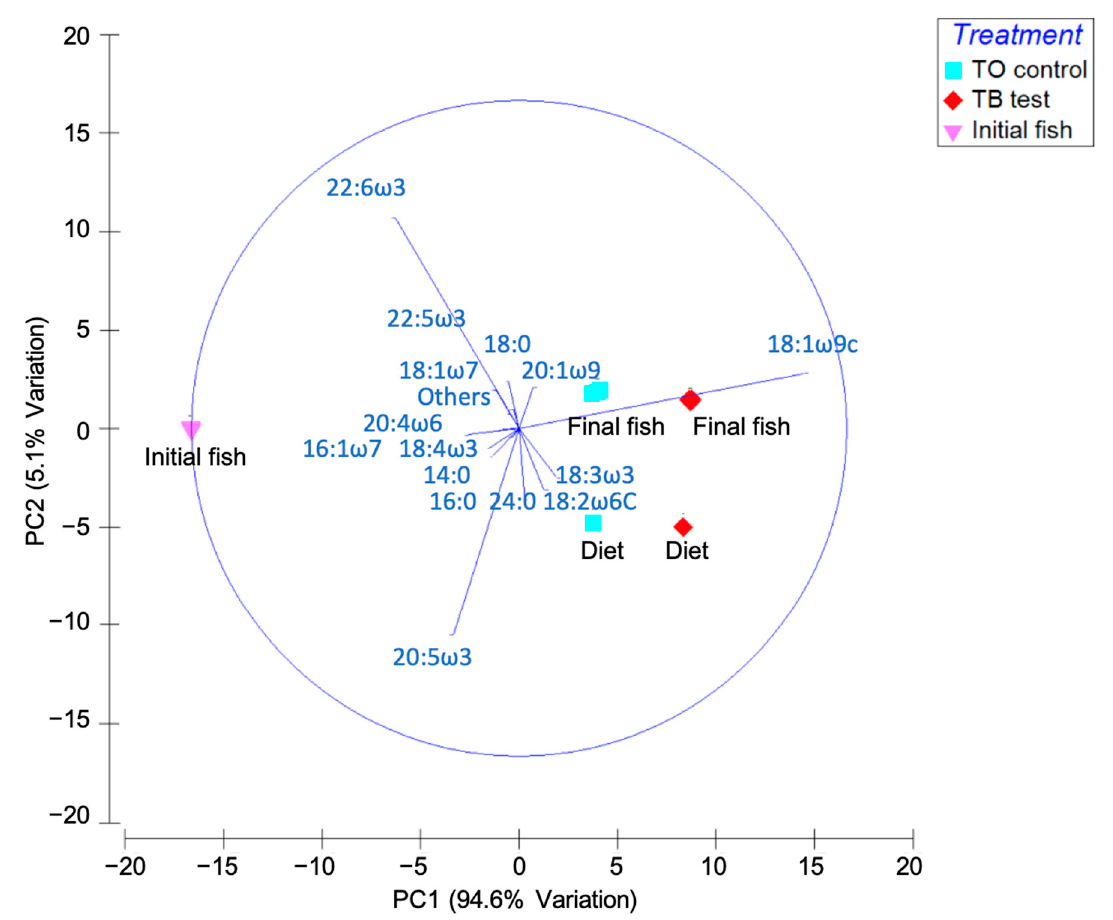
Figure 1. Principal component analysis (PCA) plot of fatty acid (FA) composition ( > 1% in at least one sample) of diets, the initial fish and the final fish.